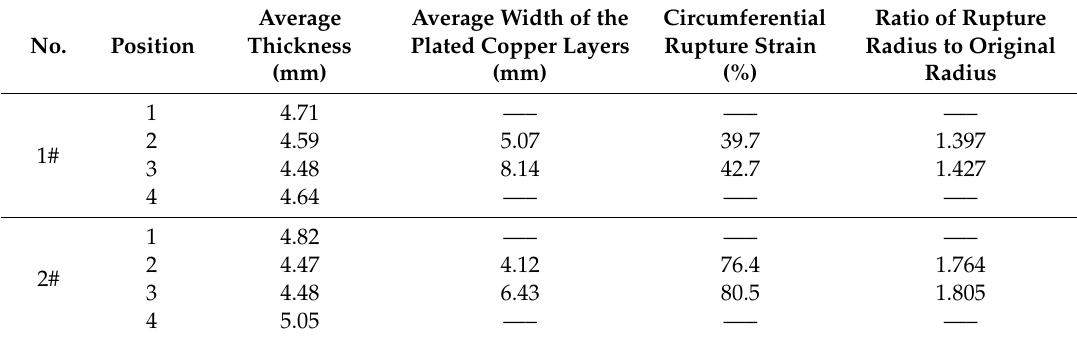
Table 2. Size characteristics of the recovered fragments from di ff erent